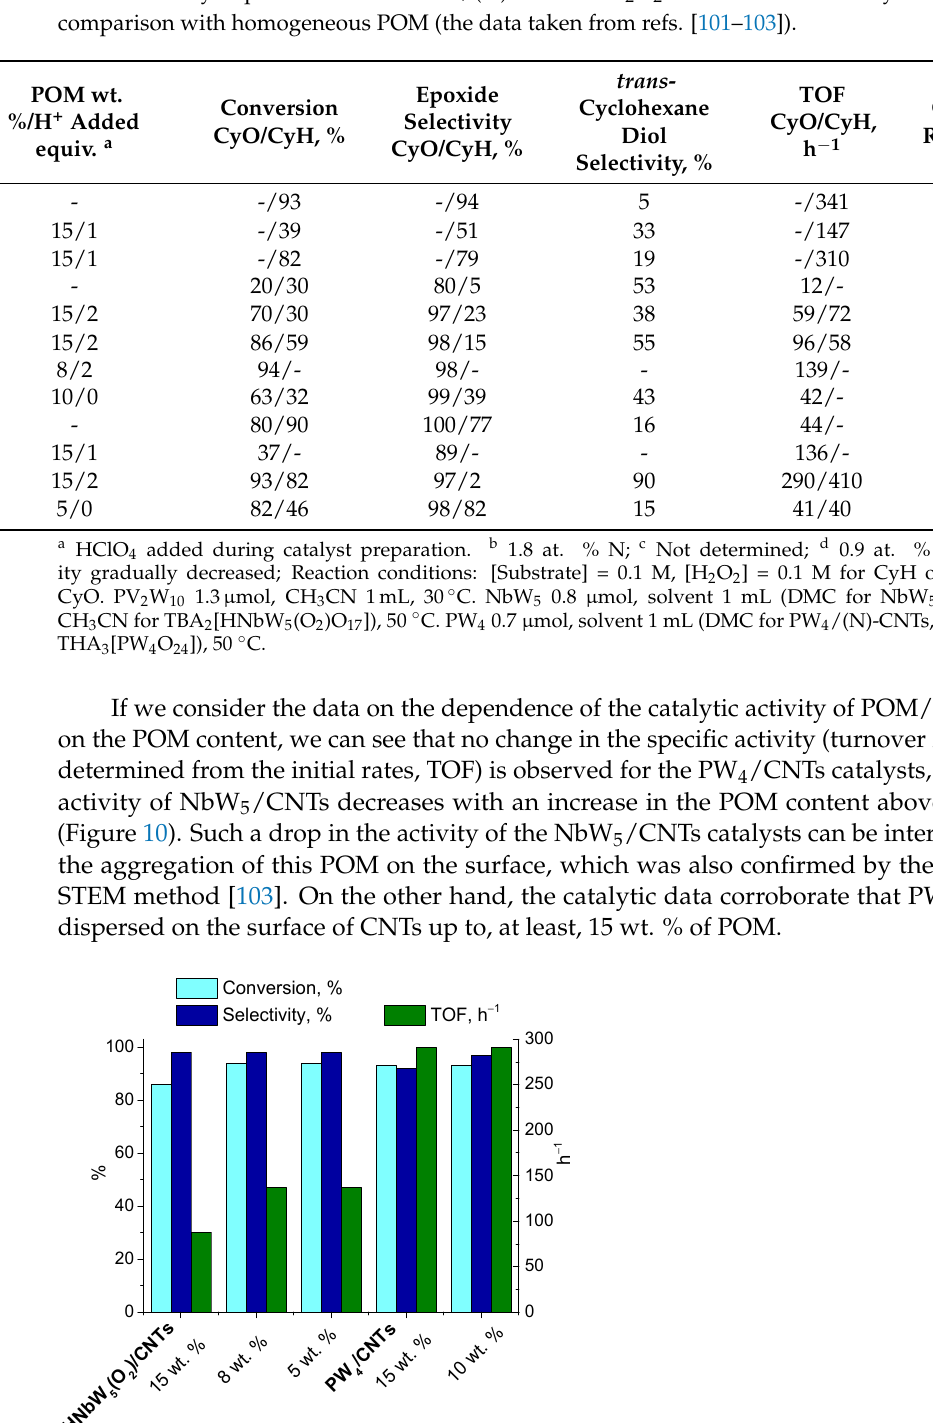
µ mol PW µ mol NbW 4 or 0.8 5